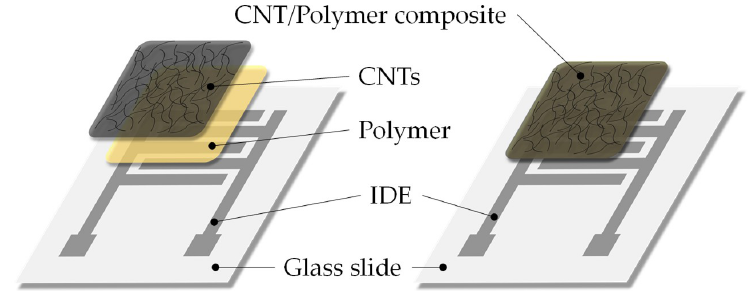
Figure 4. All inkjet-printed chemical gas sensor based on polymer and CNT networks [21].